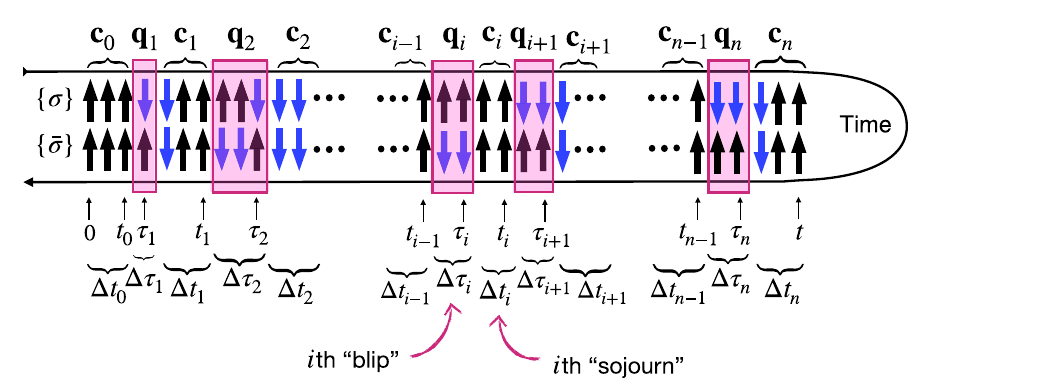
FIG. 6. Illustration of the “ sojourn-blip ” parametrization in Eq. (42) of a generic spin trajectory on the Keldysh